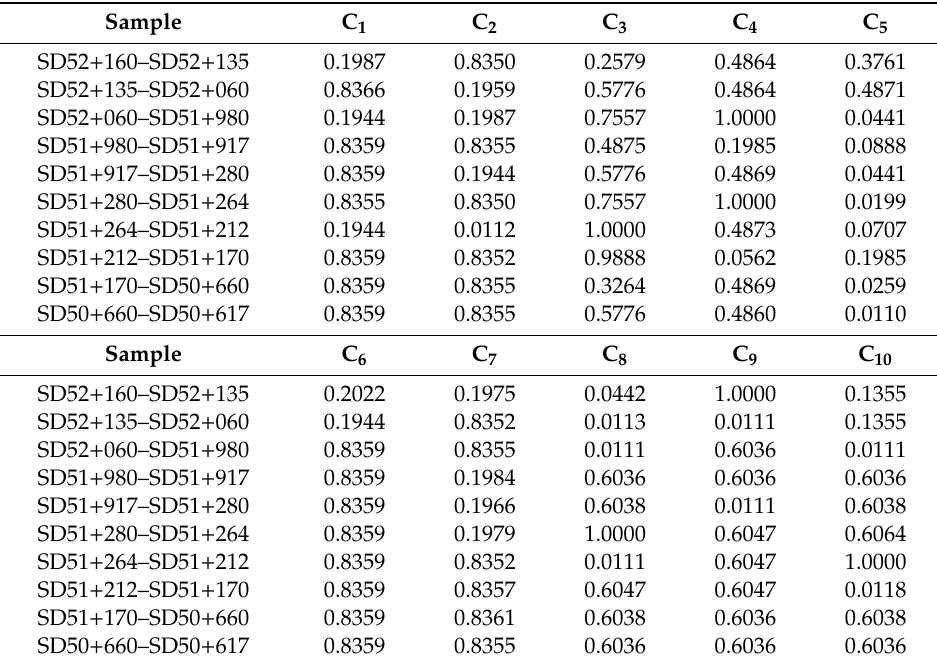
Table 7. Certainty degrees of assessment indices C 1 ~C 10 .